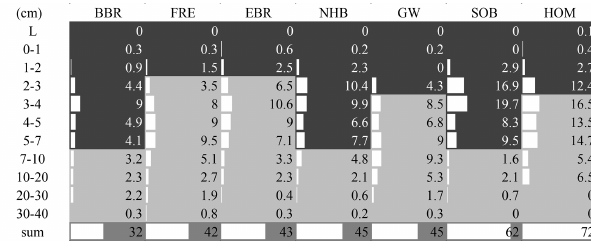
Figure 2. Recovered 15 N-labeled leaf litter (% 15 N excess recovery per plot) within the soils after 5.5 years of leaf litter exchange at seven European beech ( Fagus sylvatica L.) sites. The organic layer ( > 15% C) is indicated by dark grey filled area and mineral soil by light grey filled area. L: loose leaf